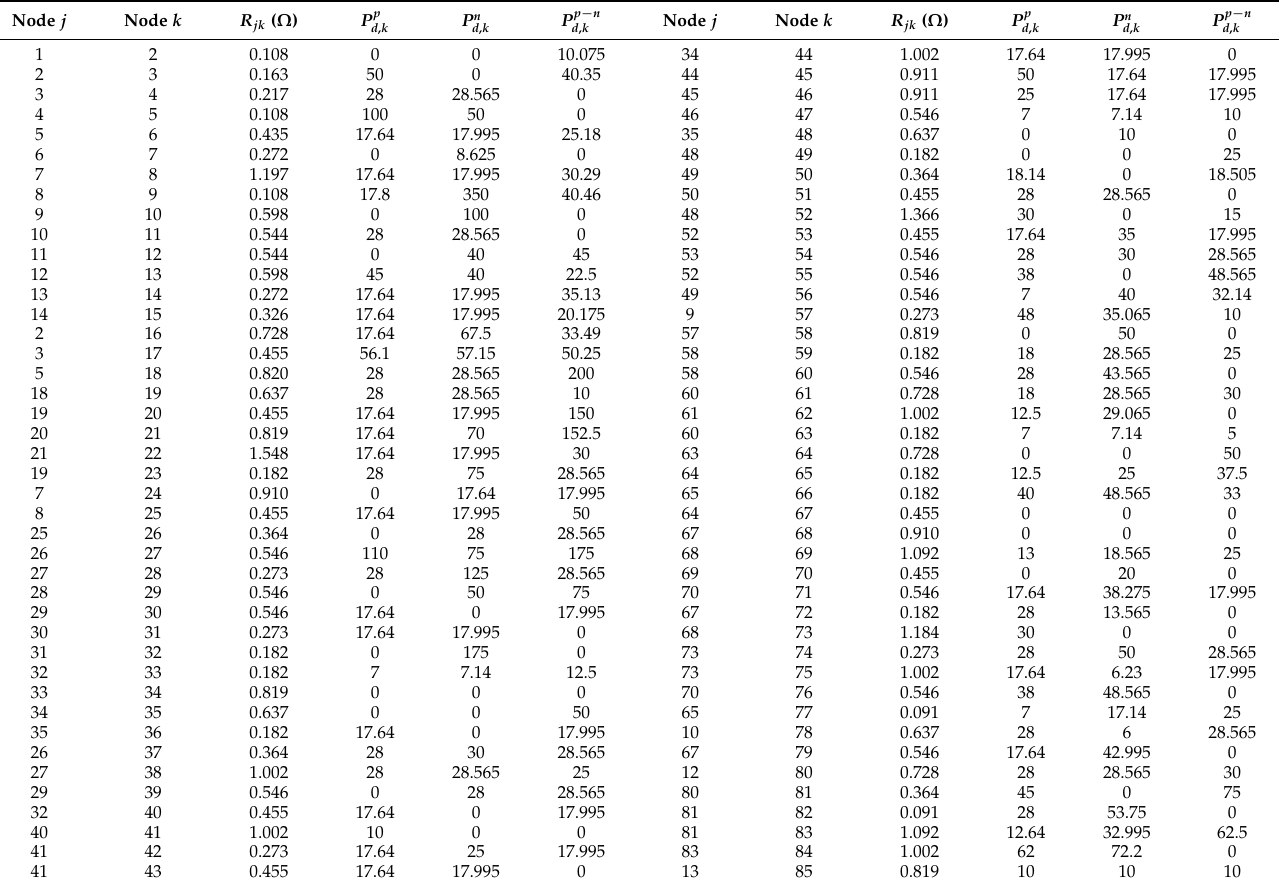
Table 2. Data for the 85-bus system (all powers in kW).